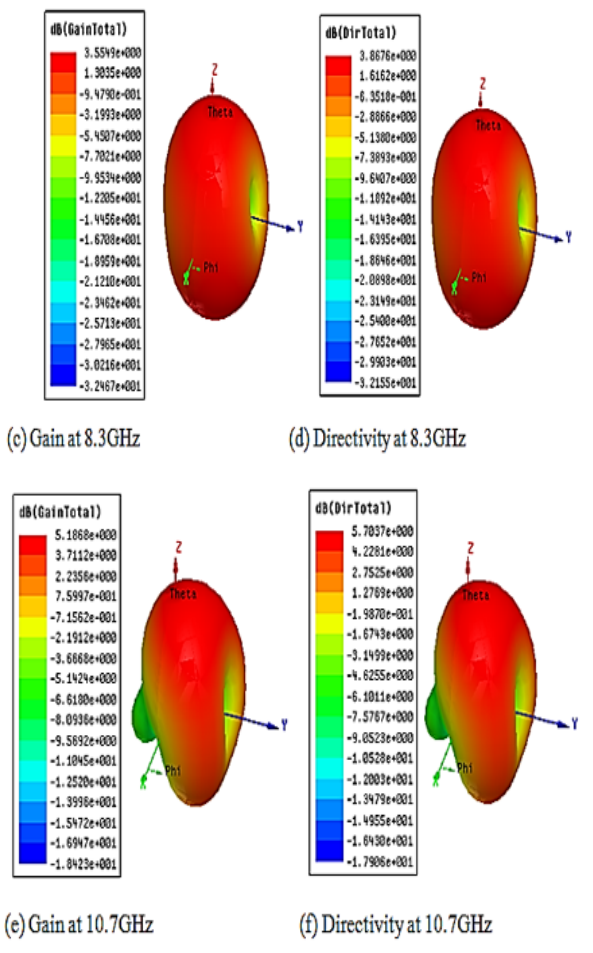
Figure 12: 3D Polar Plot Gain and directivity at three resonance Frequncies (5.5, 8.3 and 10.7)GHz